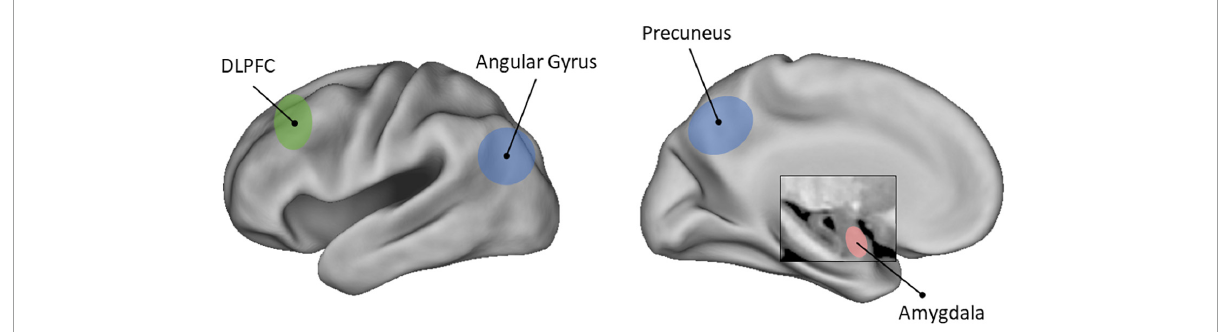
FIGURE2 Brain regions that support changes in emotion due to shifting visual perspective during AM retrieval. Precuneus and angular gyrus (blue-colored) support the representation and updating of memories from a particular visual perspective. When emotional regulation goals are present, additional recruitment of dorsolateral prefrontal cortex (DLPFC; green-colored) helps to further and attenuate emotional arousal in the amygdala